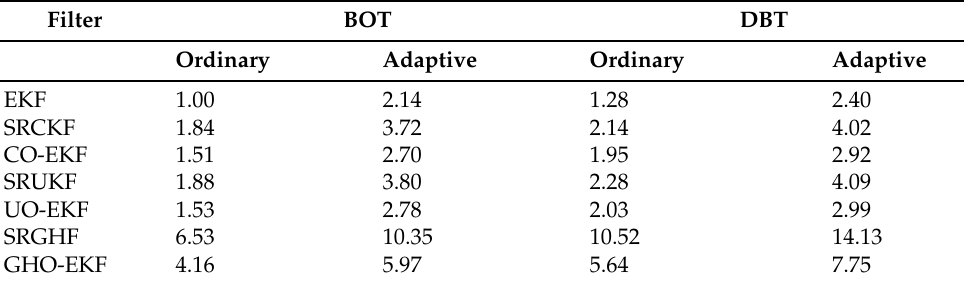
Table 4. Relative execution times of the different filters for BOT and DBT. Filter